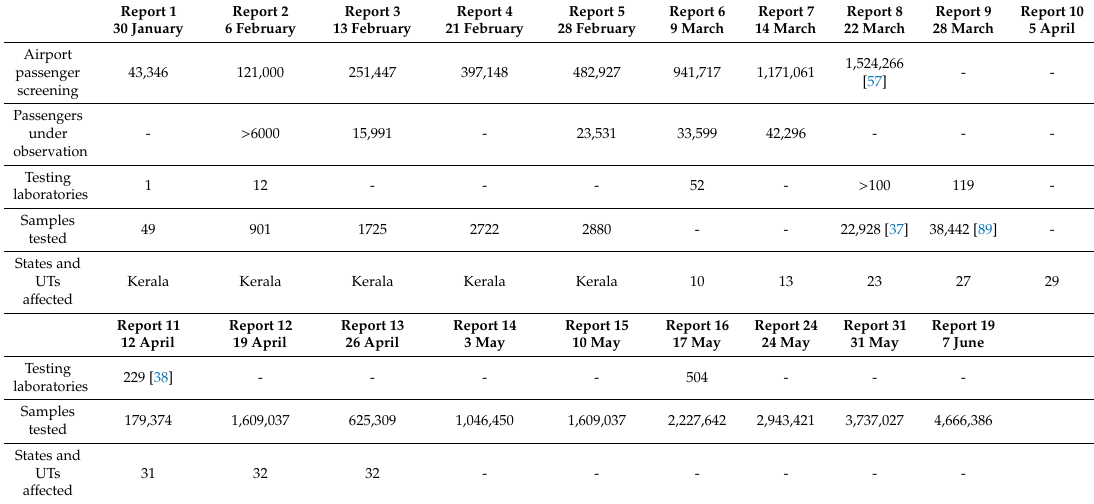
Table A2. Development of Covid-19 outbreak: an overview of WHO India situation reports